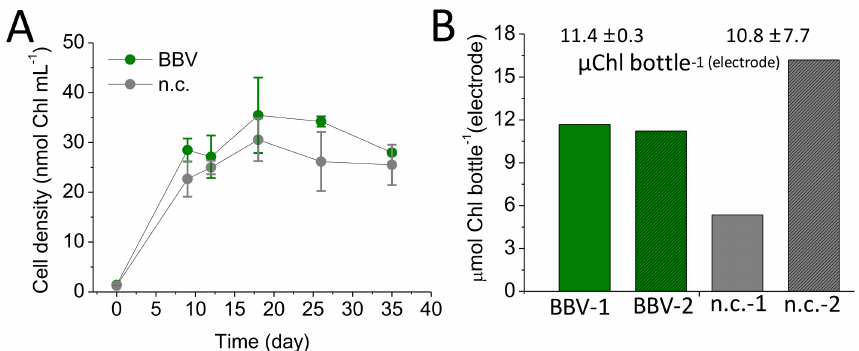
Figure 5. Algal cell growth. ( A ) Growth curves of C. sorokiniana for the wired BBV systems (green line) and for the unwired negative control (grey line) over the entire experimental run (35 days). ( B ) Chlorophyll amounts ( µ mol Chl) derived from the algal cells attached to the anode into the BBV systems (green bars) and from the algal cells attached to the anode into the unwired negative control (grey